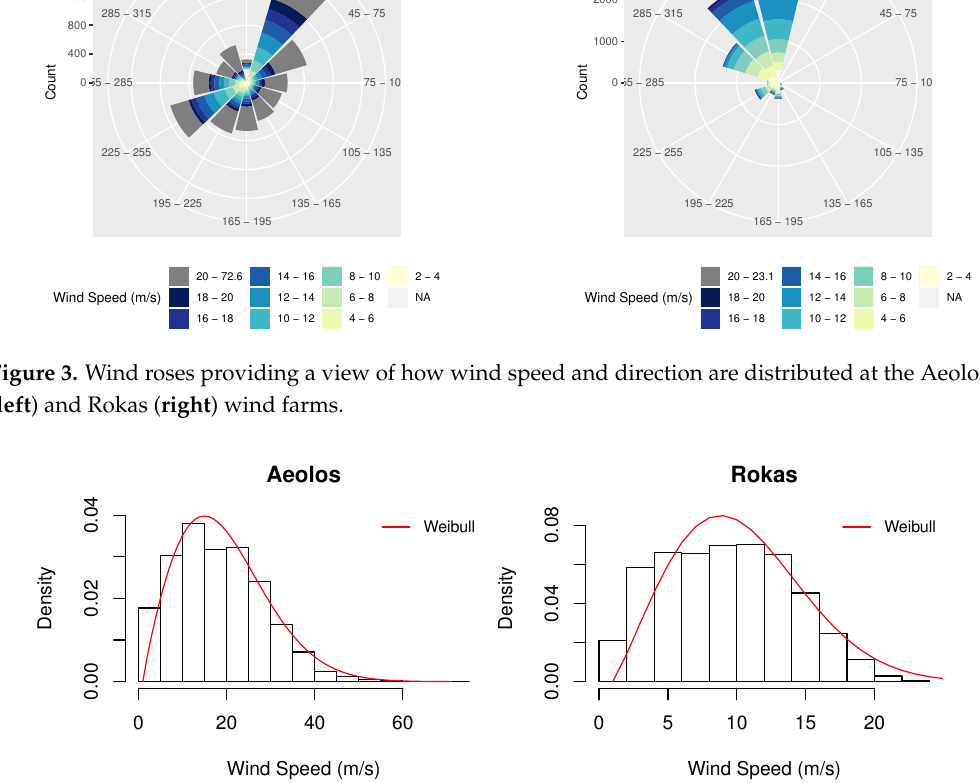
Figure 4. Weibull distributions of the wind speed at the Aeolos ( left ) and Rokas ( right ) wind